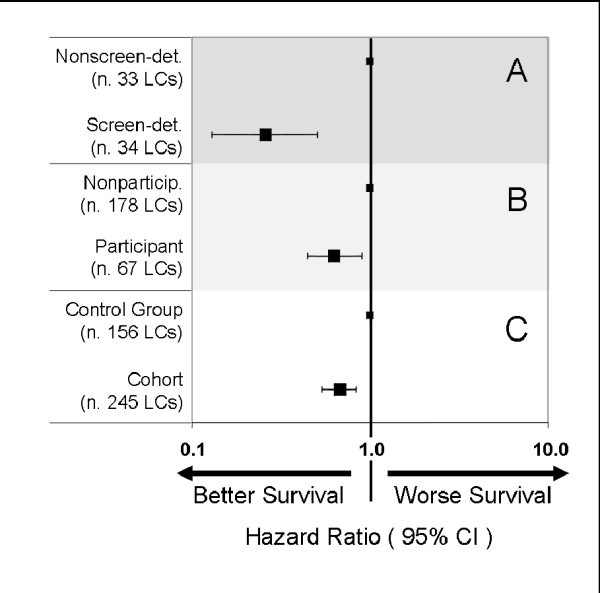
Multivariate analysis (Cox-proportional hazard model) of the impact of lung cancer (LC) screening on survival. Shown are (A) analysis of 67 LCs of participants (screen- vs. nonscreen-detected), (B) analysis of 245 LCs of the cohort (participants vs. nonparticipants), and (C) analysis of 401 LCs (156 LCs of control group vs. 245 LCs of the cohort). All the models were adjusted for gender, age, pack-years and histology.